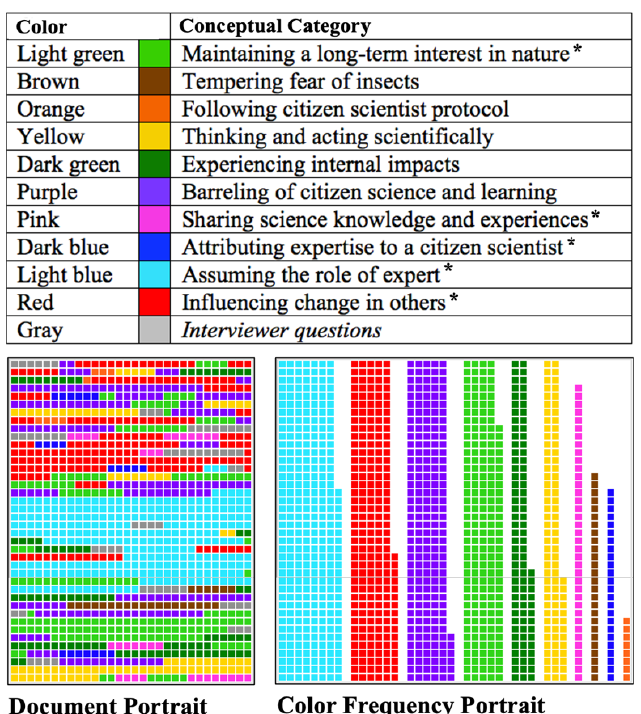
Figure 1. An example of document and color frequency portraits [MAXQDA 12] generated for each interview. *Those conceptual categories with an asterisk are the focus of this research, as they were the most closely tied to the social relationships and influences that the research participants could have on those in their social circles. Descriptions of the additional conceptual categories are available in Lynch [72].